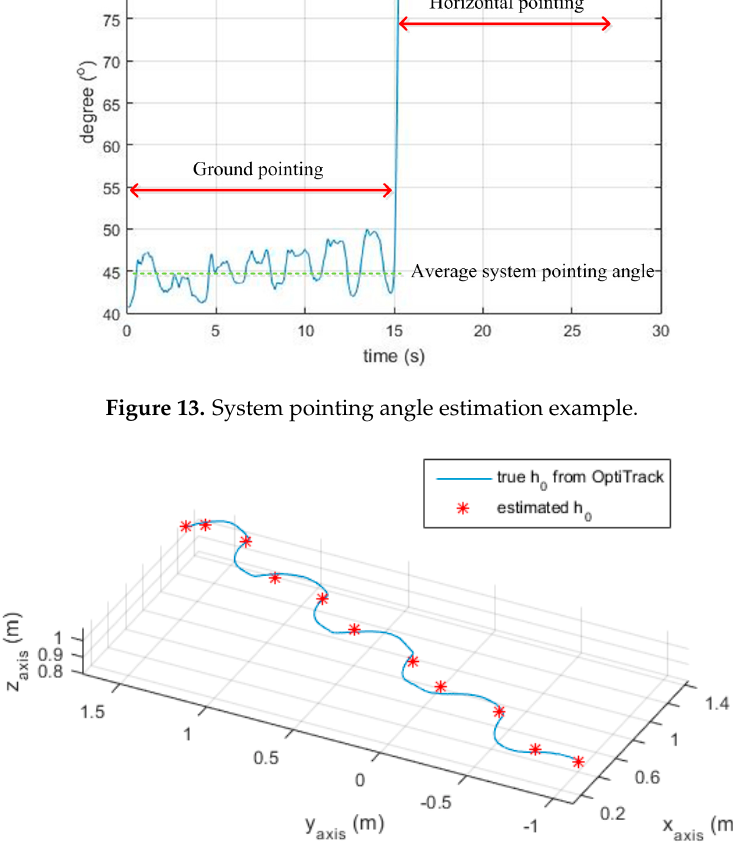
Figure 14. Estimated and true h 0 .